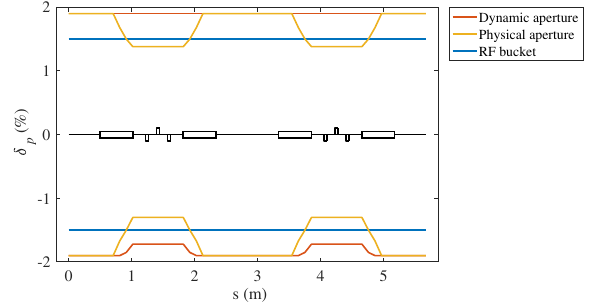
FIG. 23. Momentum aperture limited by different source.